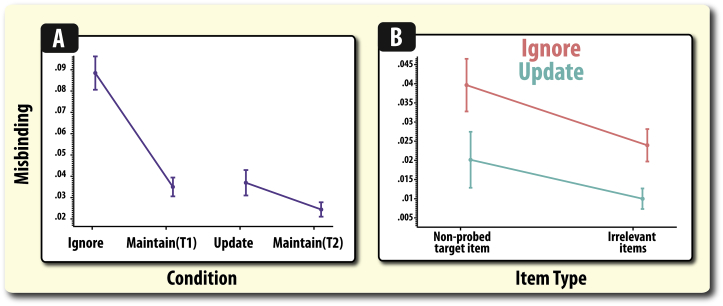
Total misbinding according to condition and by item type. A) Ignoring irrelevant information disproportionately increased misbinding, both compared to its temporal control (Maintain T1) and when the number of presented items was matched (update condition). Note, misbinding here is total misbinding to all incorrect items (Fig. 3). B) Misbinding in the ignore and update conditions according split according to the type of item that participants were misreporting (misbinding). Note, misbinding has been averaged across both irrelevant items. In both graphs, error bars reflect standard error of the mean (SEM).